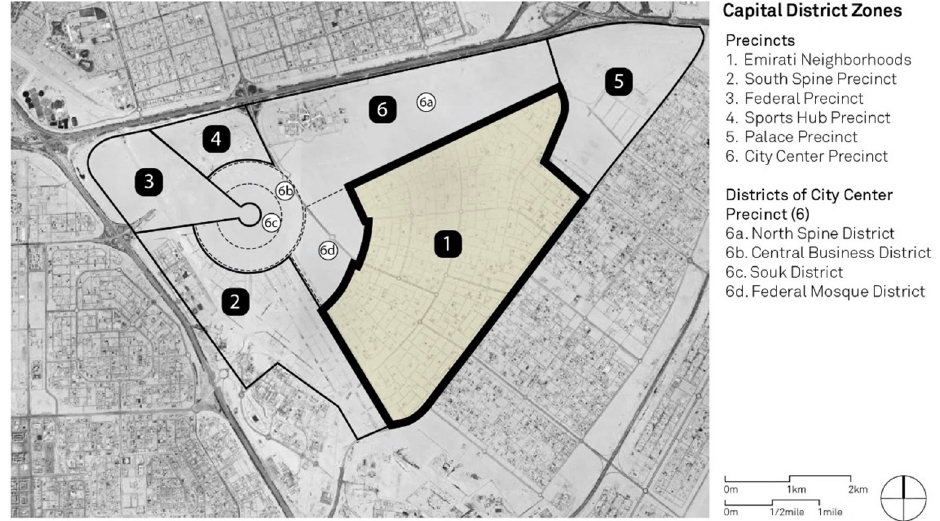
Figure 1. The Capital District Zones Diagram adapted by the authors from Abu Dhabi Urban Planning Council Report 2009 [8].